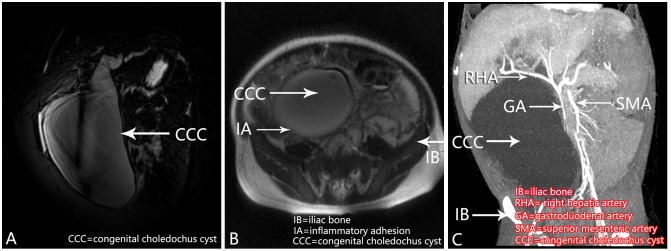
A 1-year old female with cyst descension into the introitus pelvis.A, Pancreatic and common channel was not detected in MRCP. B, Axis T2WI imaging showed the cyst descension into introitus pelvis. Inflammatory adhesion can be found in the lower-right side of the cyst. C, contrast-enhanced multislice spiral computed tomography (multiplanar reformation imaging) showed the cyst occupies large intra-abdominal space, displacement of vessels, modified the pelvic and duodenal anatomy.